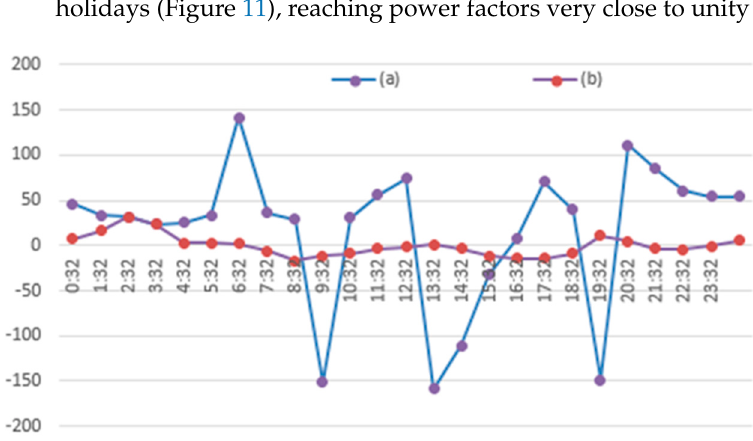
Figure 11. Transformer reactive powers, in kVAR, after applying actions for optimizing the operation of capacitor bank Q c 2 : (a) working days, and (b) holidays. Table 8. Power factor and reactive energies each day and annual penalizations resulting from applying the above actions on the second capacitor bank ( Q c 2 ). Type of Day